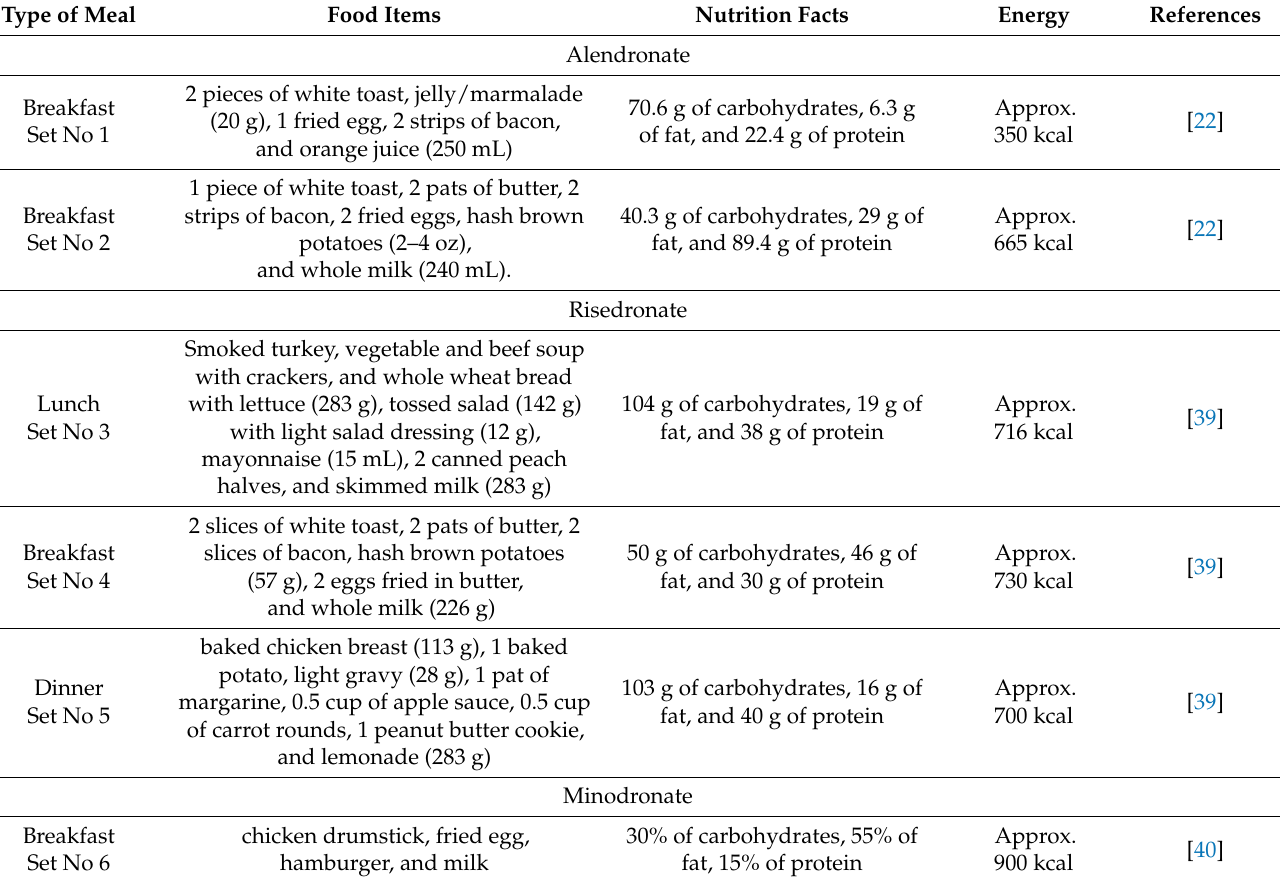
Table 1. Detailed composition of the meals used in the studies described in this